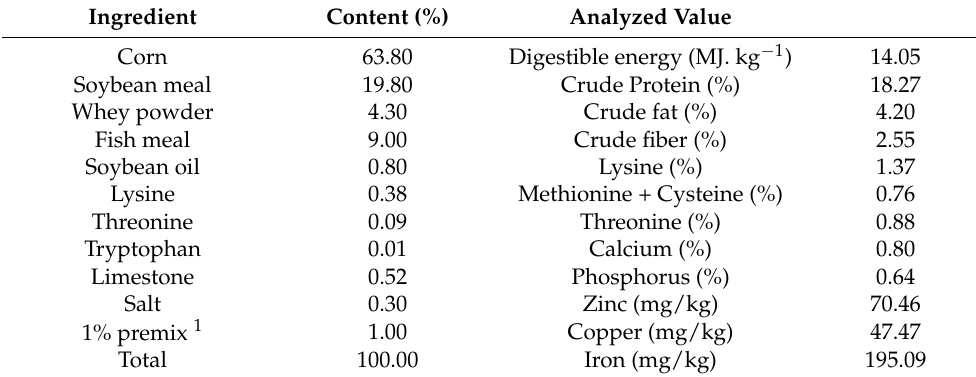
Table 1. Composition of basal diet (as-fed basis) for